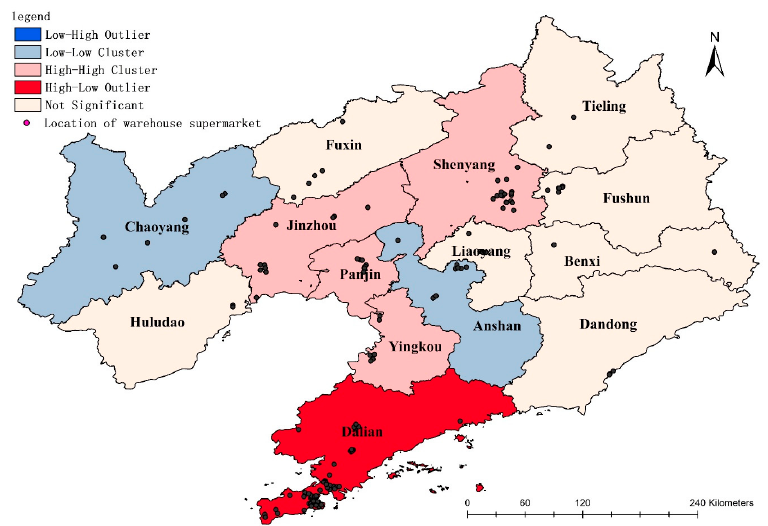
ISPRS Int. J. Geo-Inf. 2023 , 12 , x FOR PEER REVIEW Figure 7. Moran Scatter Map of Warehouse Supermarkets in Liaoning Province. Figure 7. Moran Scatter Map of Warehouse Supermarkets in Liaoning Province.